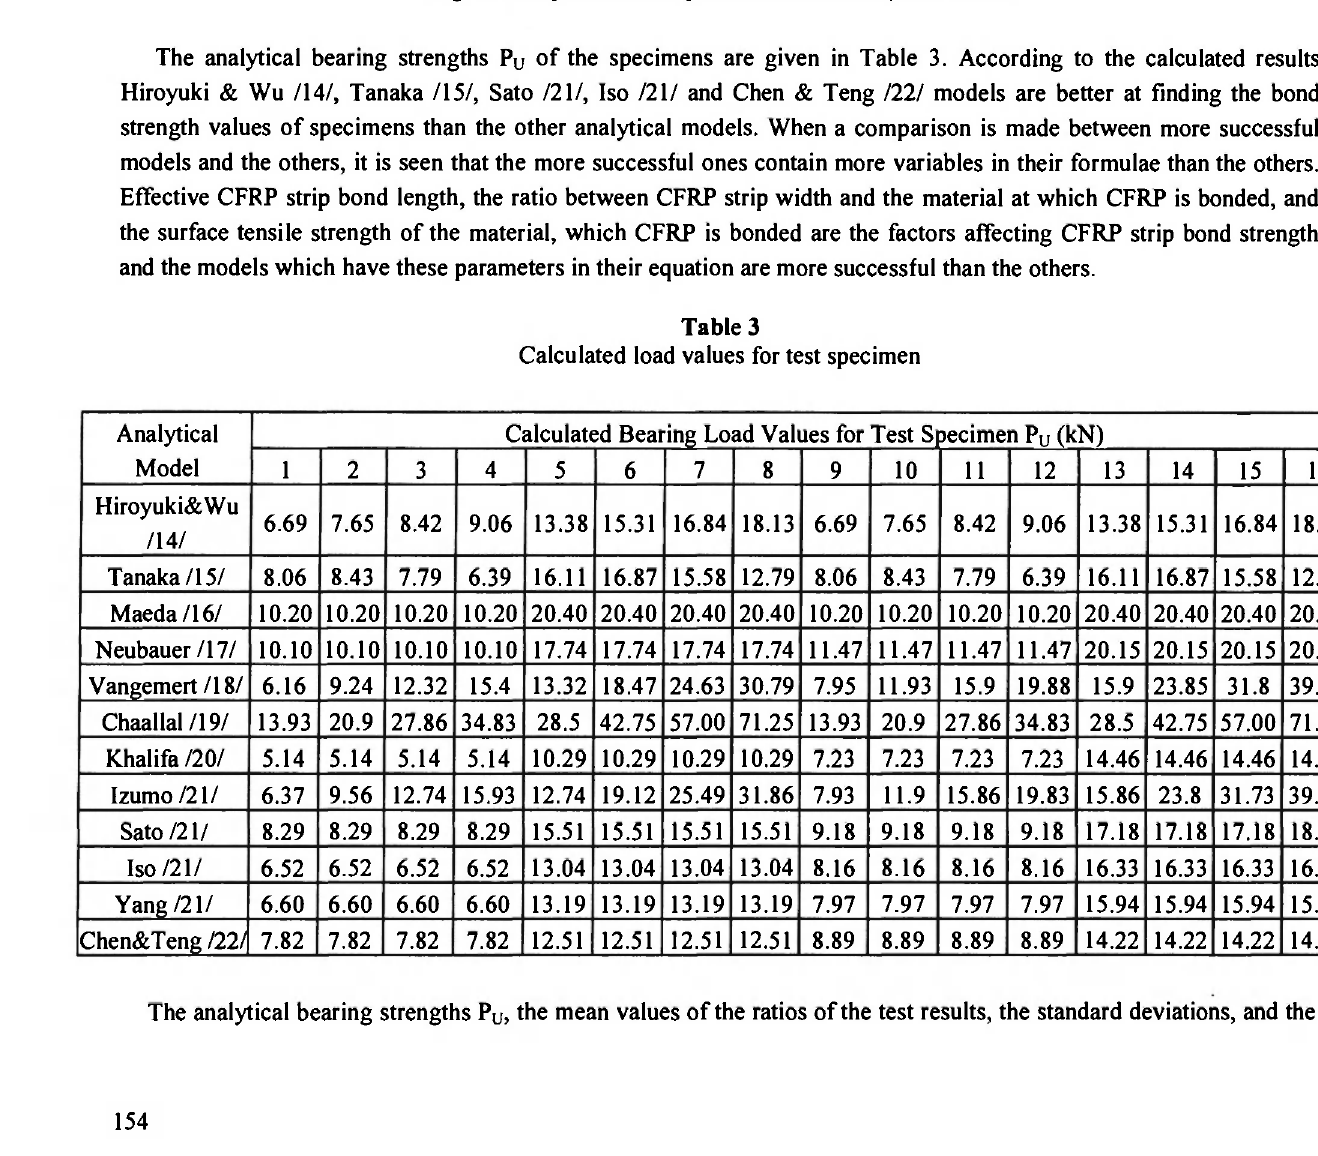
Fig. 6: Comparison of Experimental and Analytical